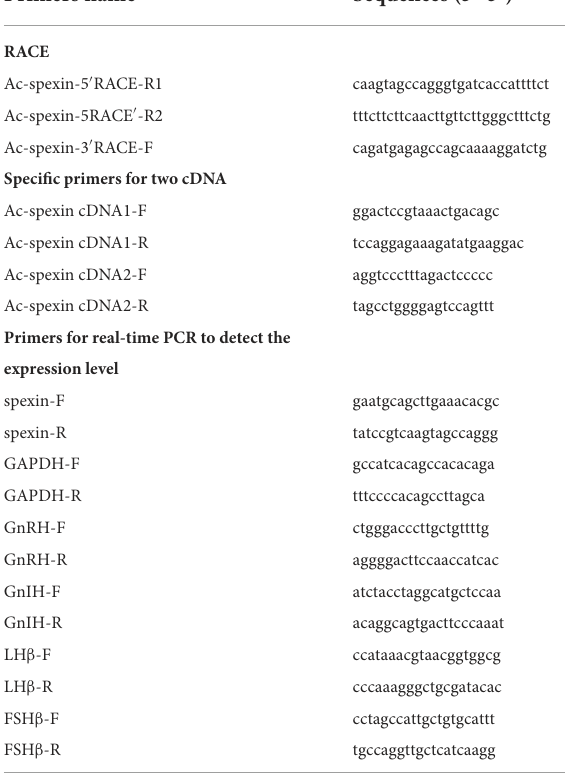
TABLE 1 Primer sequences used in this